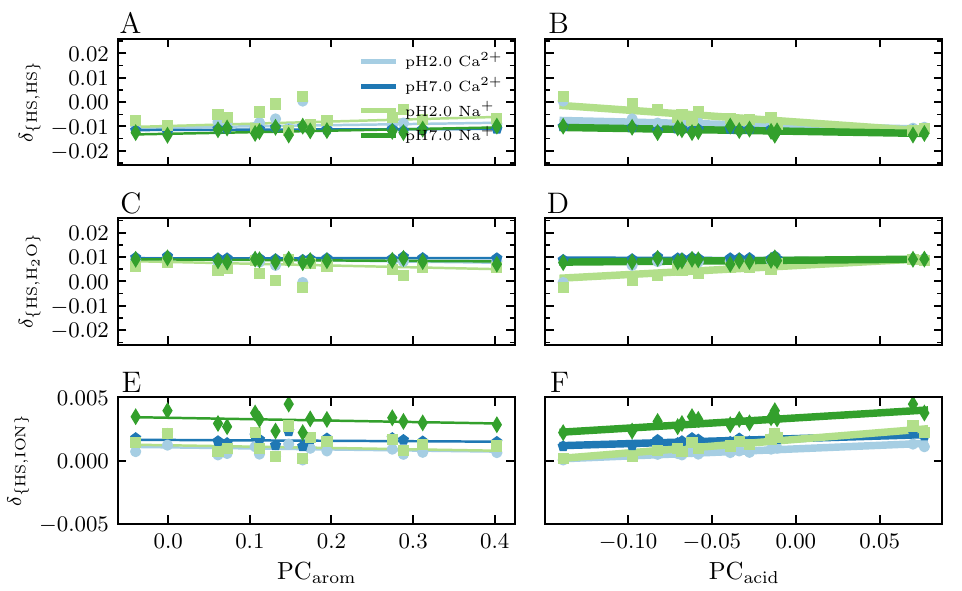
Figure 6. Preferential solvation of humic substances with different species (HS, H 2 O and Ca 2 + ) of the standard humic substances models. Plots show the preferential solvation with ( A , B ) the humic substances, ( C , D ) water and ( E , F ) cations (calcium or sodium) in function of their PC arom and PC acid . Each point represents the average over four independent simulations with error bars representing the standard error. Notice the different y -axis scales in these plots.